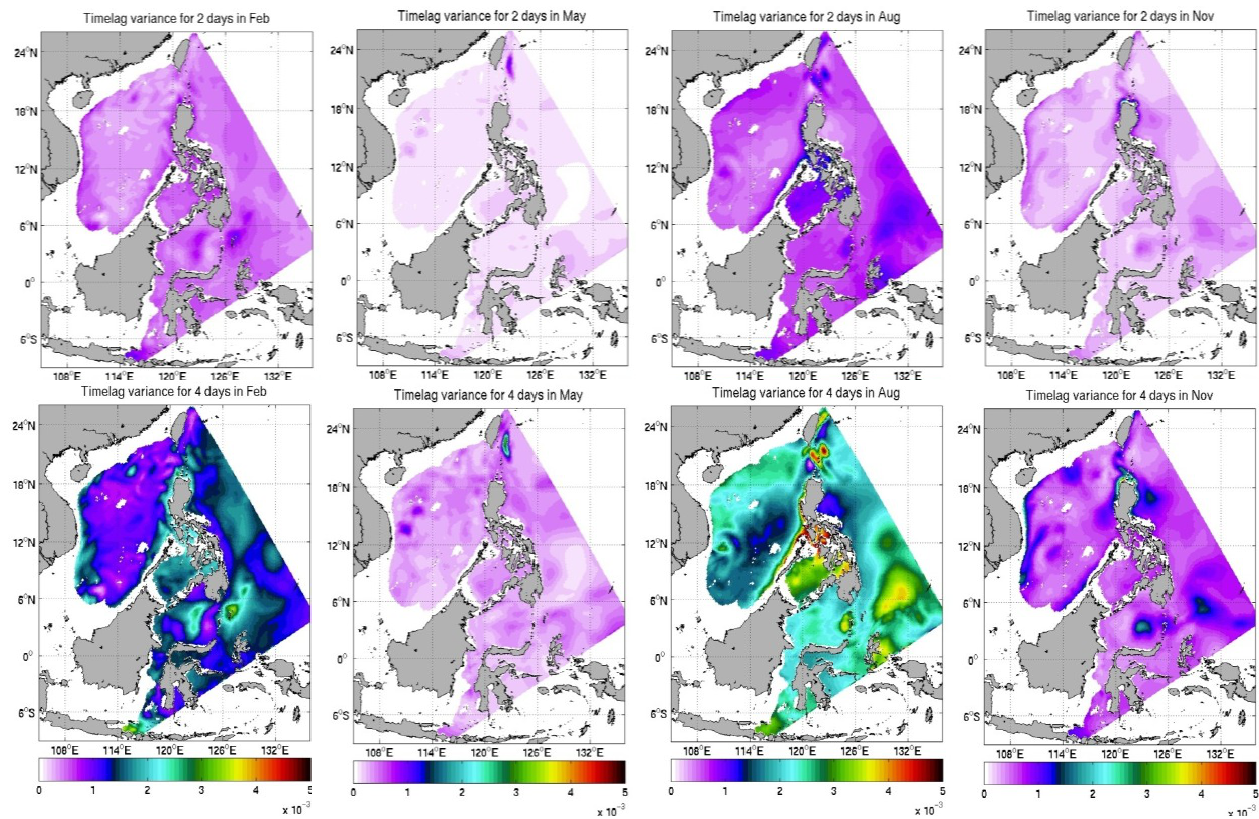
Fig. 6. The time-lag variances of SLA for 2 (upper) and 4 (lower) days in the months February, May, August, and November. The regions with the water depths shallower than 200m are masked.